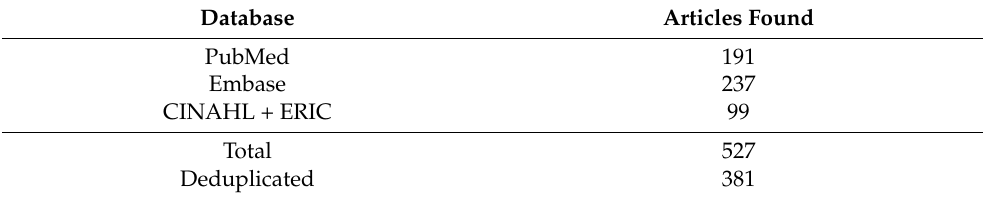
Table A1. Results databases.